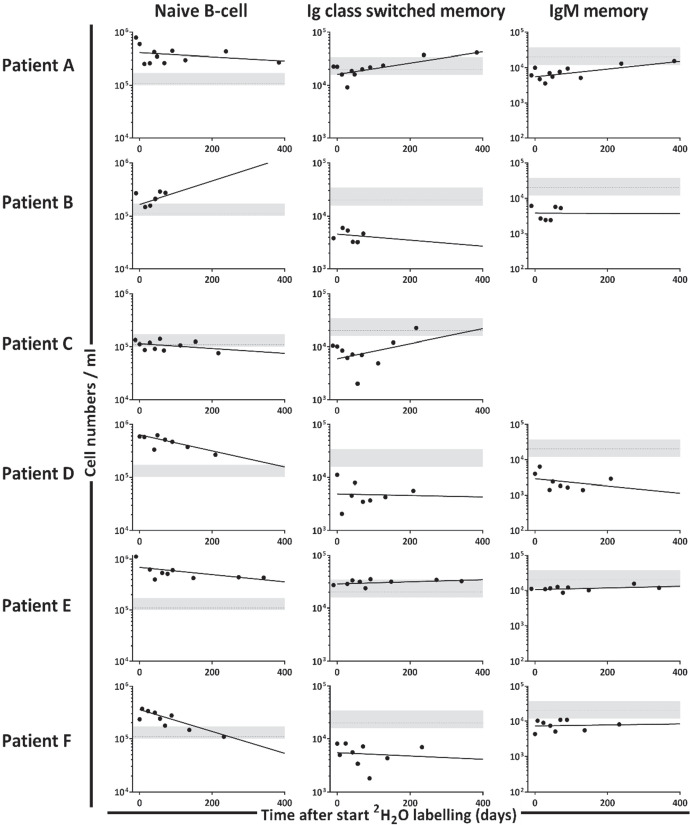
Best fits of B-cell numbers in autologous hematopoietic stem cell transplantation (autoHSCT) patients.Best ﬁts (black lines) to the normalized cell number data (black dots). Absolute numbers (cells per milliliter of blood) of naive (CD19+IgM+CD27-), Ig class-switched memory (CD19+IgM-CD27+), and IgM+ memory (CD19+IgM+CD27+) B-cells were corrected for noise as described in Materials and methods. The median cell numbers (dotted gray line) and the corresponding IQR (interquartile range, gray area) for healthy controls are shown.